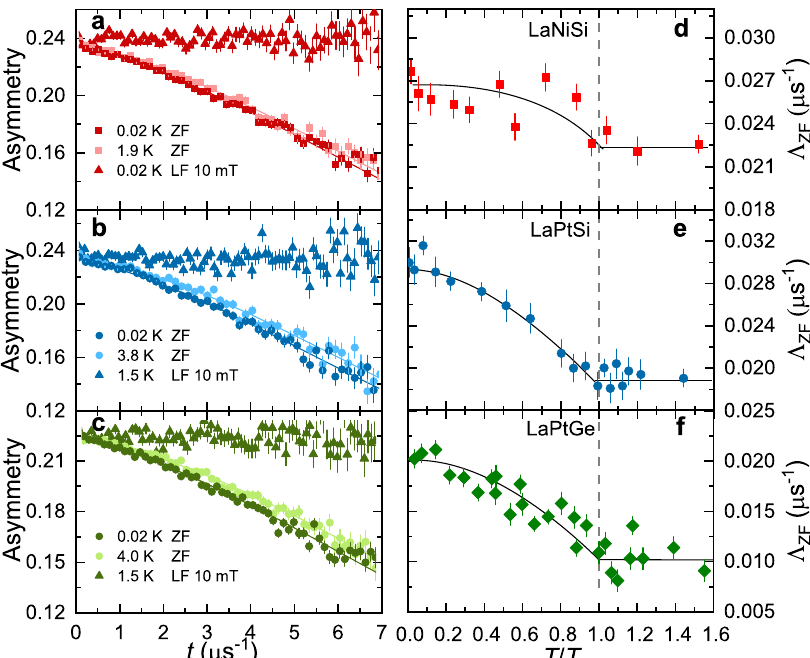
Fig. 3 Probing TRS breaking superconductivity via ZF- μ SR. a – c Zero- fi eld μ SR spectra collected above and below T c in LaNiSi ( a ), LaPtSi ( b ), and LaPtGe ( c ). In all cases, the lack of any oscillations implies a lack of long-range magnetic order. Solid lines through the data in a – c are fi ts to Eq. (2). The fl at μ SR datasets in a – c correspond to LF- μ SR spectra, suggesting that even a small longitudinal fi eld is suf fi cient to decouple muon spins from the local fi eld. d – f Zero- fi eld muon-spin relaxation rate Λ ZF versus the reduced temperature T / T c for LaNiSi ( d ), LaPtSi ( e ), and LaPtGe ( f ). Solid lines in d – f are guides to the eyes. A consistent increase of Λ ZF below T c re fl ects the onset of spontaneous magnetic fi elds, indicative of a breaking of TRS in the superconducting state, while the σ ZF is almost temperature independent (see details in Supplementary Fig. 7 and Note 5). The error bars of Λ ZF are the SDs obtained from fi ts to Eq. (2) by the musr fi t software package 52